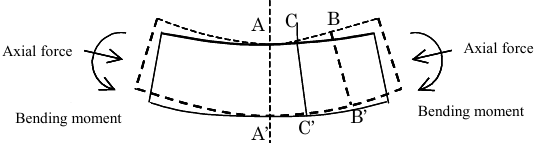
Figure 3. State of the external